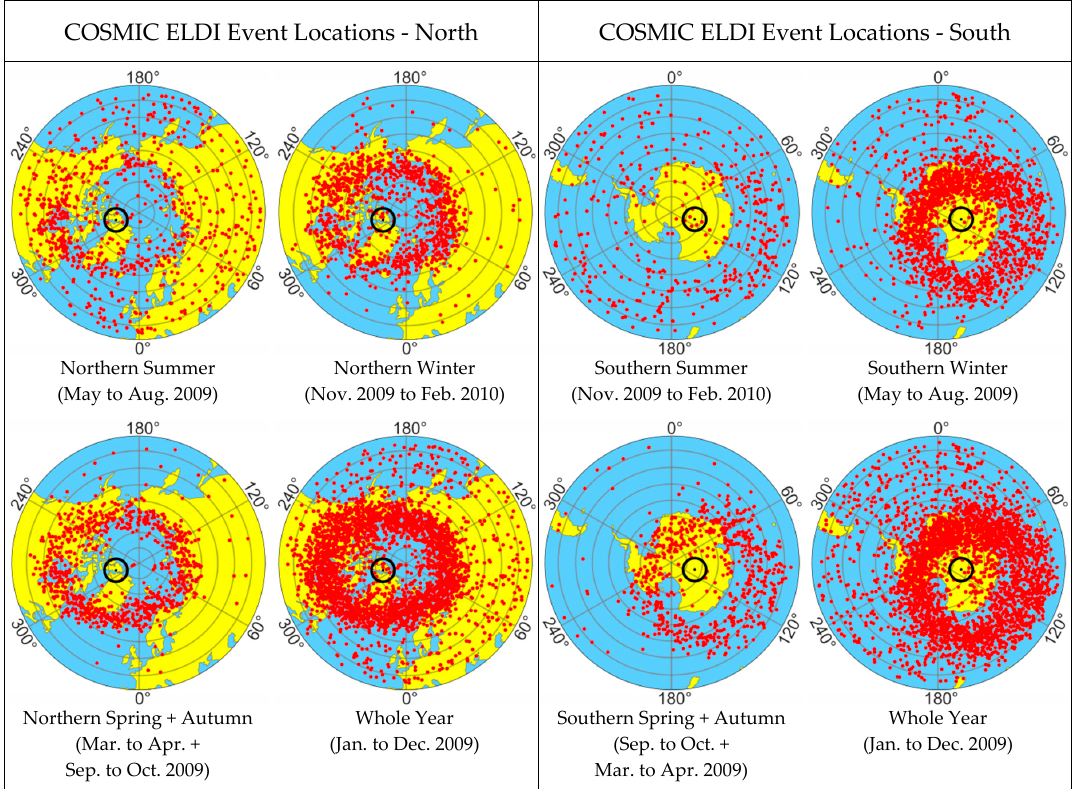
Figure 4. Geographic locations of ELDI events (red dots) for COSMIC in the year 2009. Black circles mark the locations of the geomagnetic poles. ( Left panel ) northern high latitude region; ( right panel ) southern high latitude region. ( Top left maps ) summer season; ( top right maps ) winter season. ( Bottom left maps ) a combination of spring and autumn seasons; ( bottom right maps ) whole year.